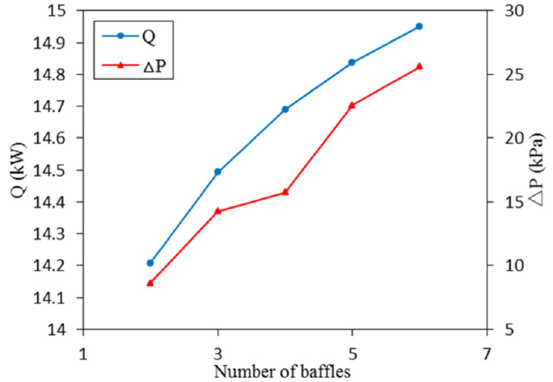
Figure 10. Heat transfer capacity and shell-side pressure drop separately versus number of baffles.